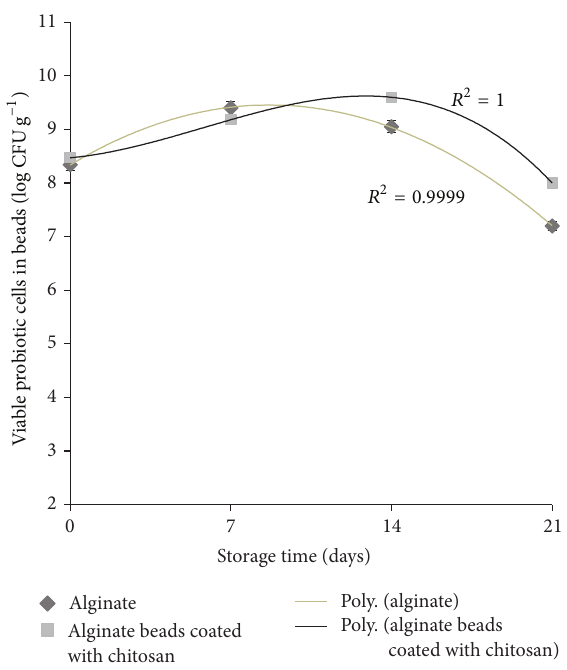
Figure 3: Viable cell number of bacteria during 21 days of refriger- ated storage, at 7 days of interval for cells in alginate beads (log CFU g −1 ) and coated alginate beads (log CFU g −1